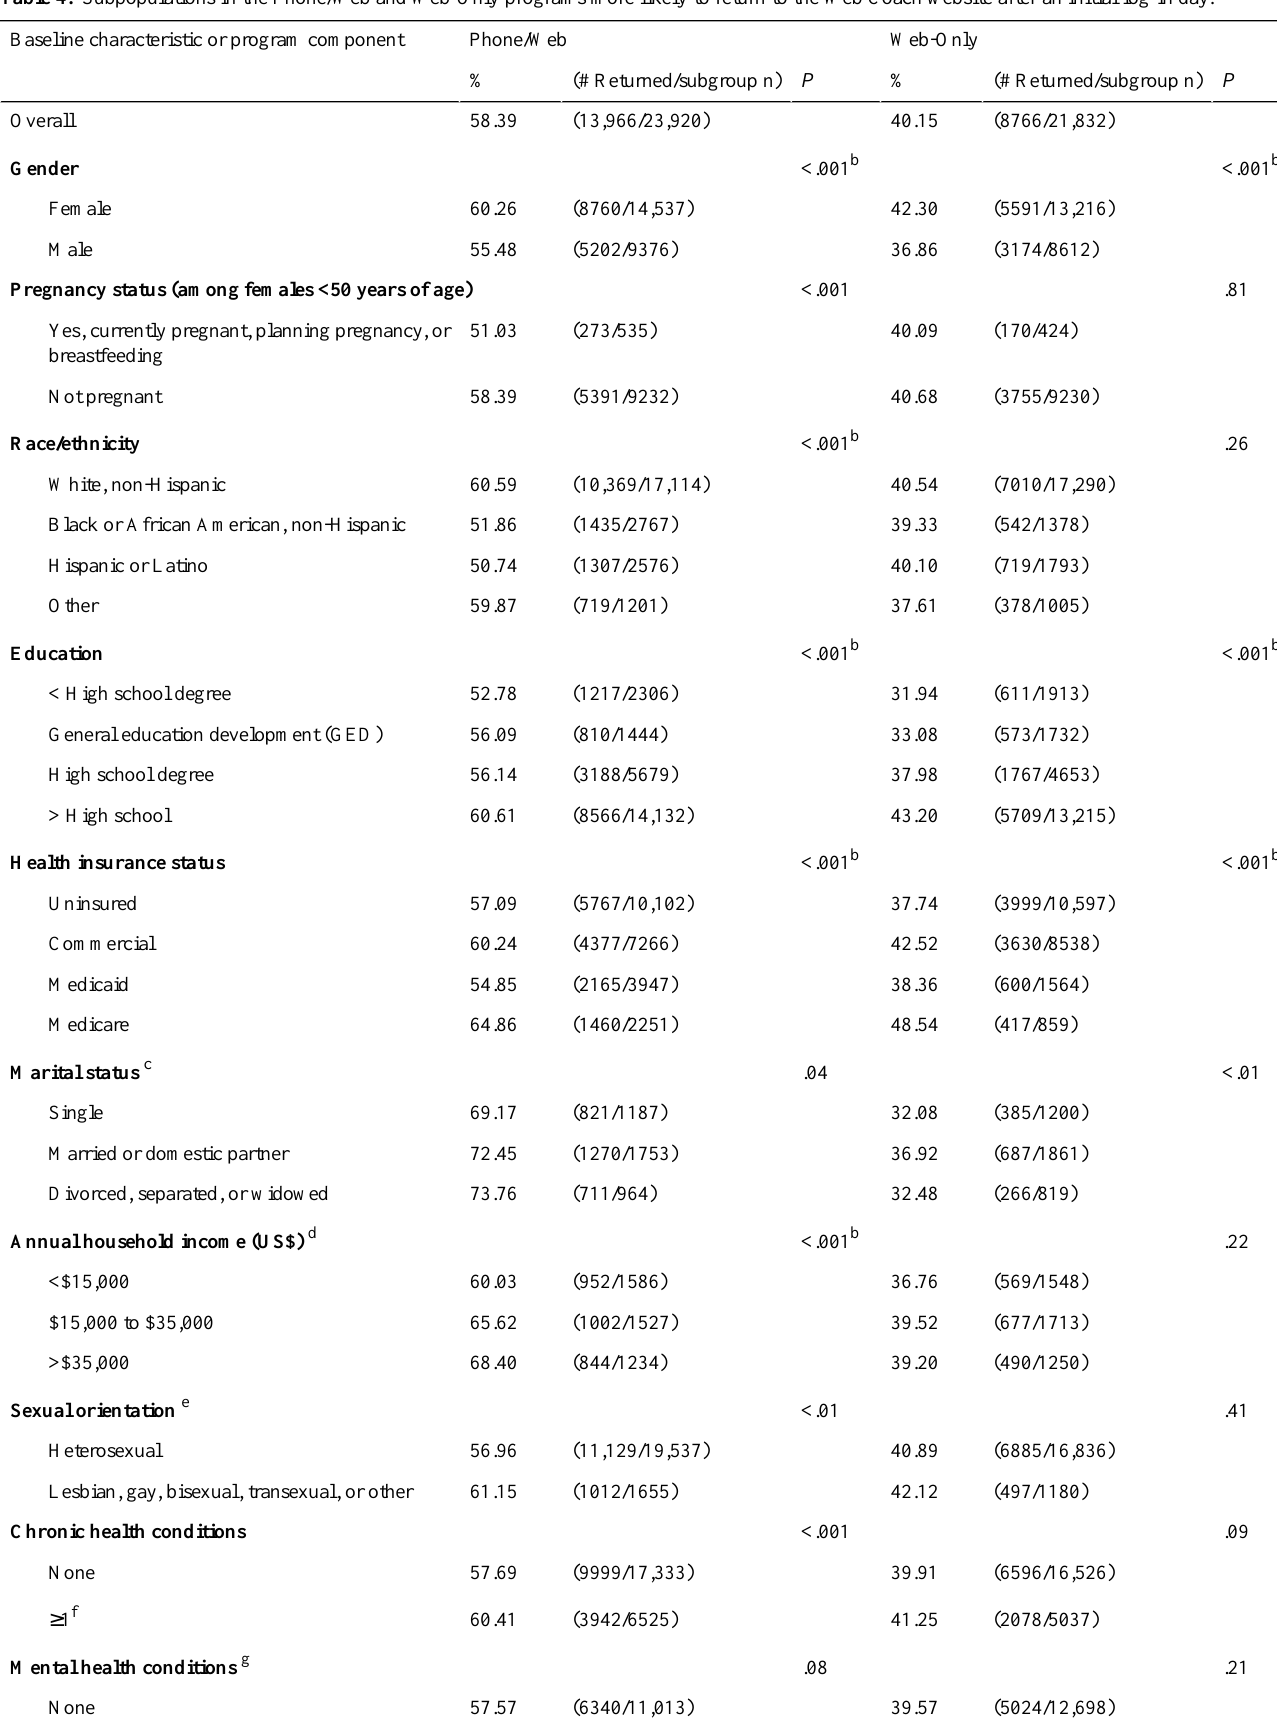
Table 4. Subpopulations in the Phone/Web and Web-Only programs more likely to return to the Web Coach website after an initial log-in day. a